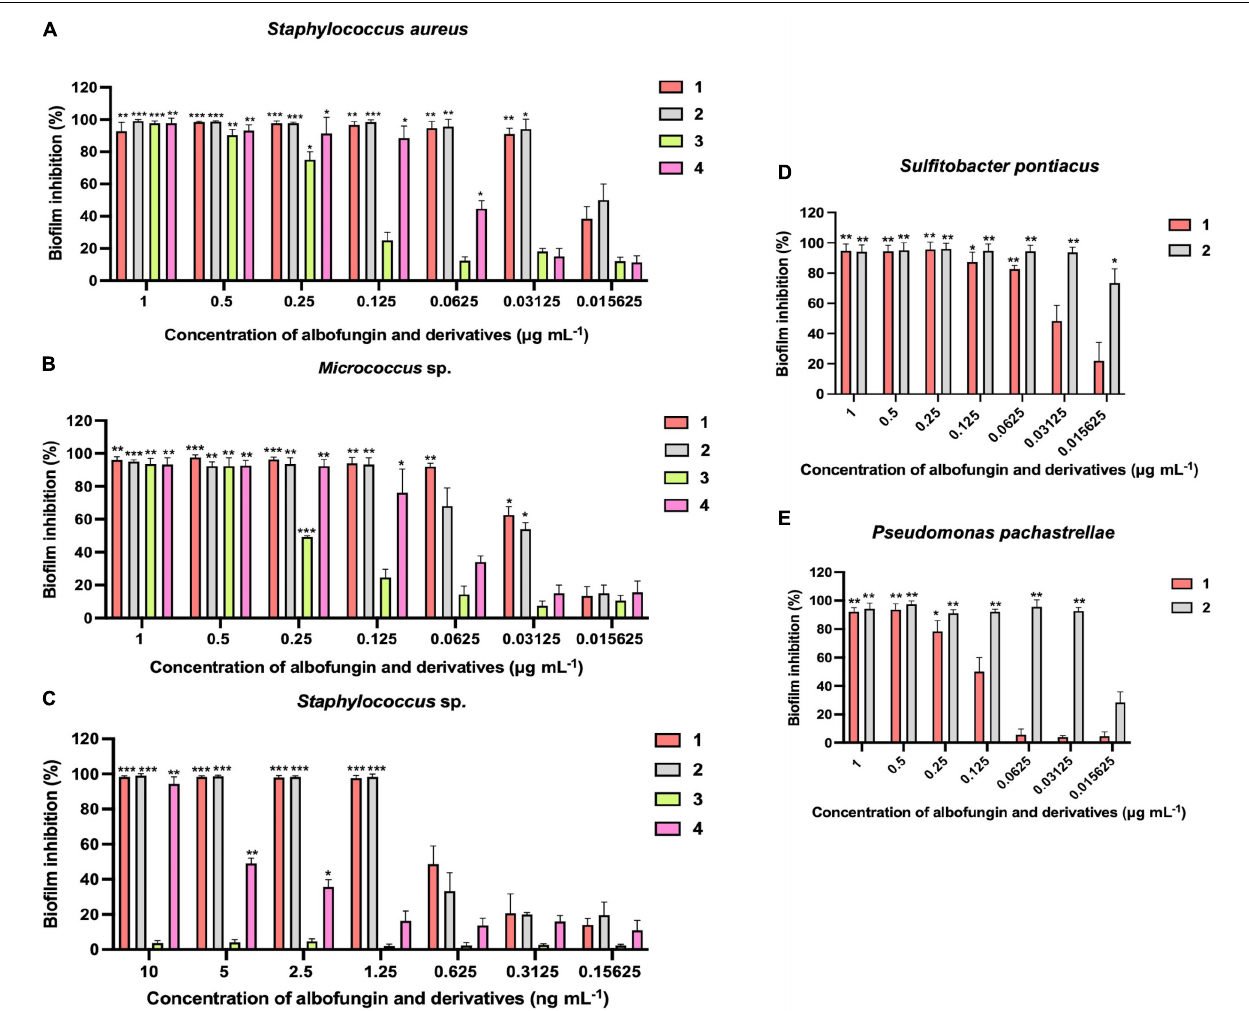
FIGURE 2 | Inhibition of biofilm formation of Staphylococcus aureus (A) Micrococcus sp. (B) Staphylococcus sp. (C) Sulfitobacter pontiacus (D) Pseudomonas pachastrellae (E) by albofungins ( 1 – 4 ). Error bars represent SD, n = 9 wells from 3 batches of microbial cultures. Significant differences were analyzed by one-way ANOVA compared with the control biofilm, * p < 0.05, ** p < 0.01, and *** p <